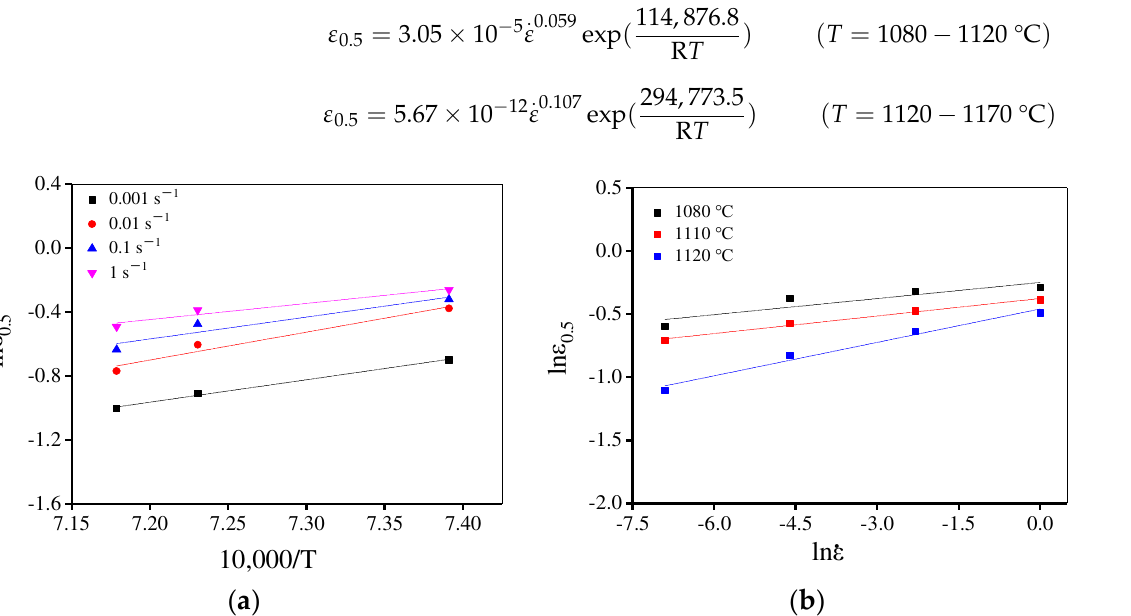
Figure 14. Relationship between ε 0.5 and deformation conditions ( a ) ln ε 0.5 –10,000/T and ( b ) ln ε 0.5 − ln